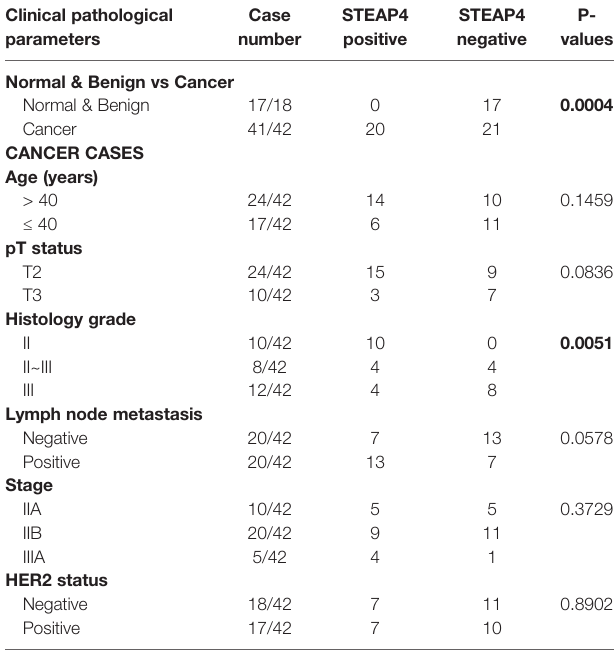
TABLE 3 | Association of STEAP4 expression with patient ’ s clinicopathological features in the TMA slides. Clinical pathological